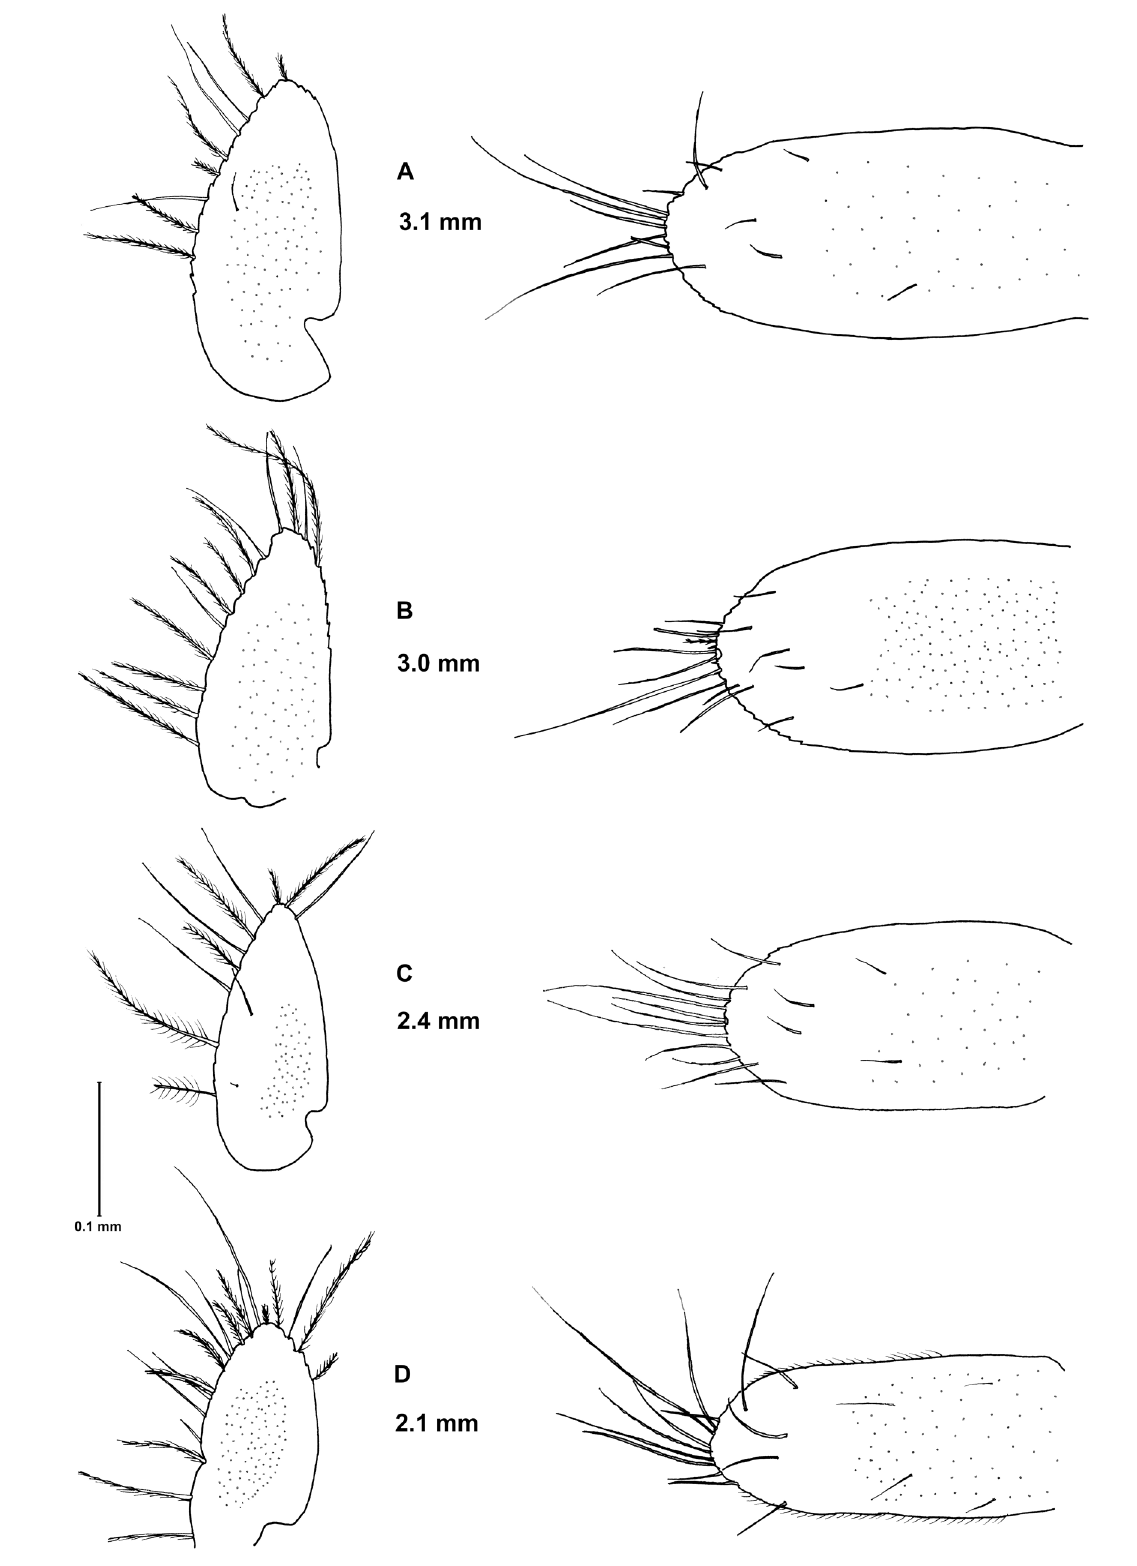
Fig. 35. Colanthura gerungi sp. nov., immature specimens of different sizes (body length in mm). (MZB Iso 111) Comparison of exopods of uropods and telson